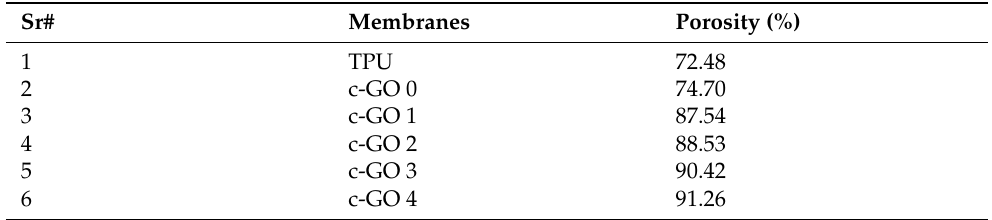
Figure 7. Pure water flux and dye rejection performance of TPU and c-GO/TPU membranes (Dye Coomassie Blue (10 ppm), pH = 7, T = 30 °C). Table 2. Porosity (%) of TPU based c-GO composite